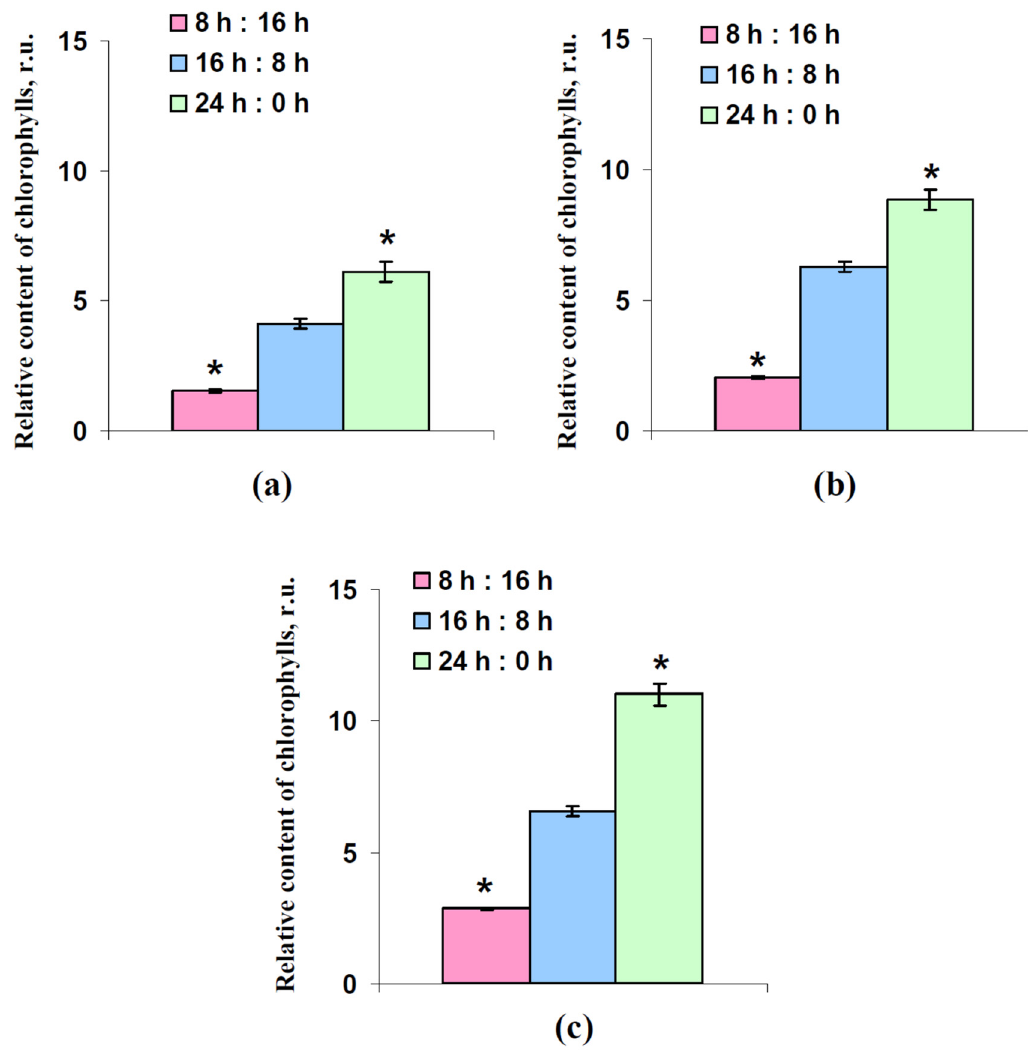
Figure 5. Relative total content of chlorophylls per leaf area after 18 days ( a ), 25 days ( b ), and 32 days ( c ) lettuce cultivation ( n = 6). “8 h:16 h” is 8 h (light):16 h (dark), “16 h:8 h” is 16 h (light):8 h (dark), and “24 h:0 h” is 24 h (light):0 h (dark). *, difference from control plants cultivated under 16 h (light):8 h (dark) were significant ( p < 0.05).